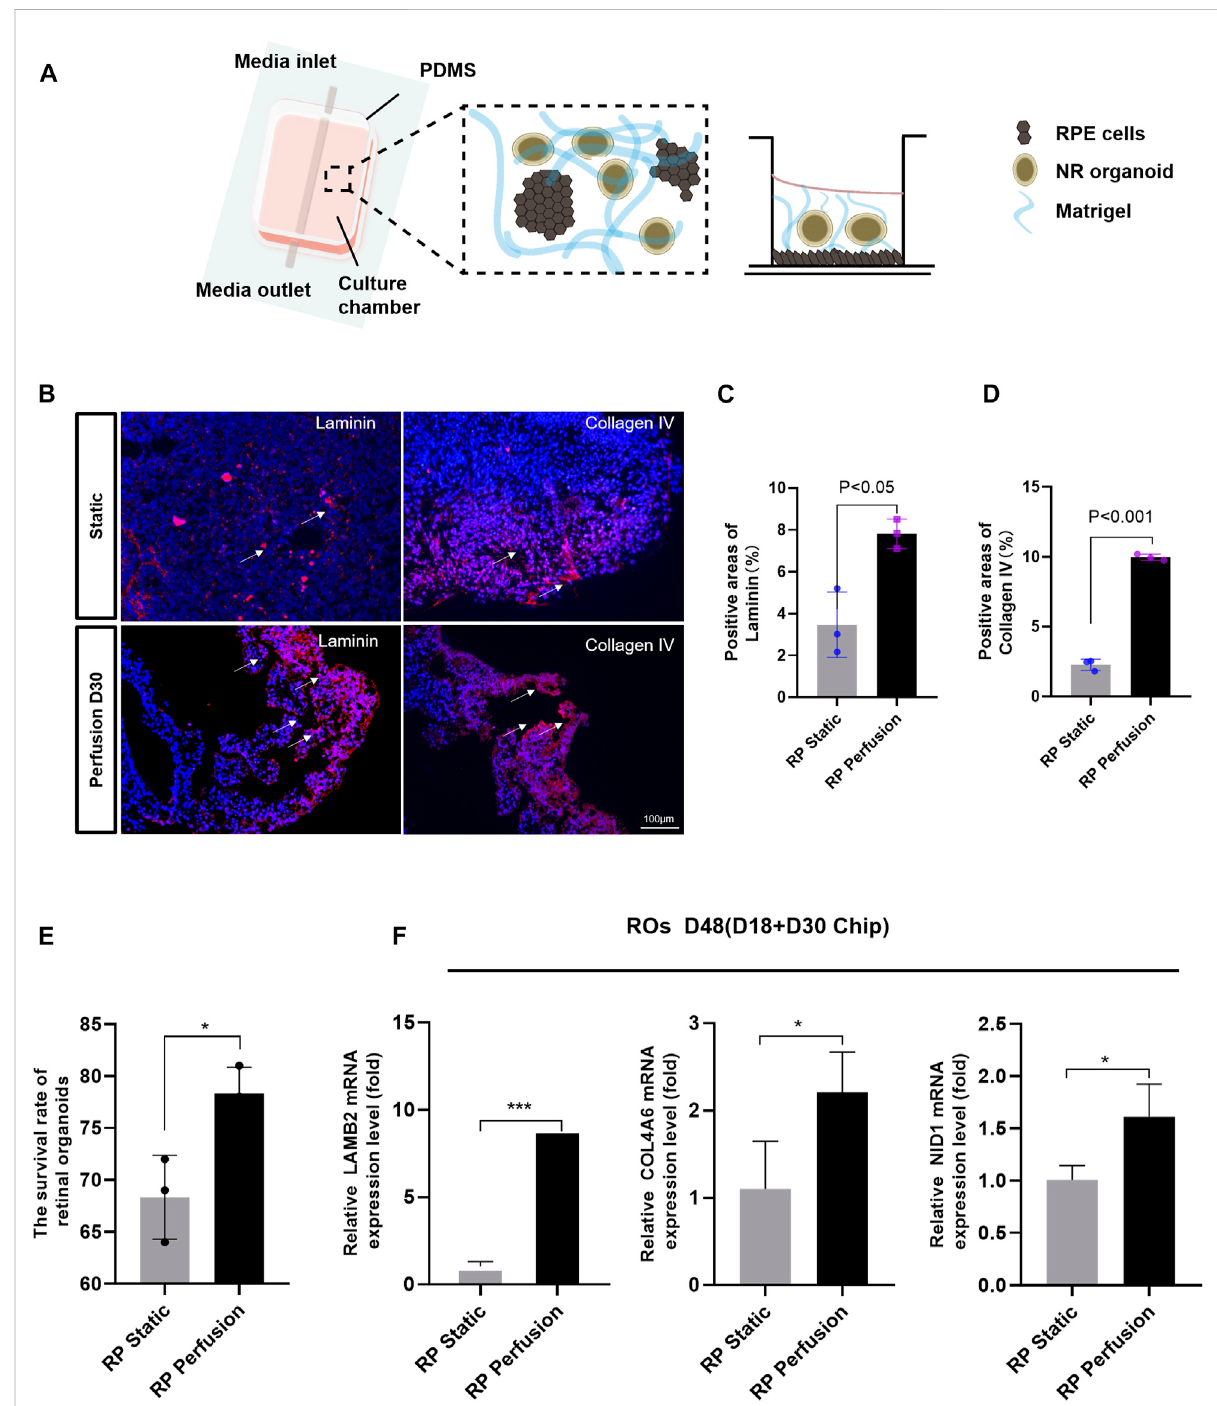
FIGURE 6 Micro fl uidicchipofperfusableROsinco-culturewithRPE. (A) Schematicofthemicro fl uidicsystem. (B) Immunostainingimagesoflaminin(red) and collagen IV (red) of ROs in response to perfusion with 200 μ L/min after 30 days compared to static control condition. (C,D) Measurements of positive areas with laminin and collagen IV. (E) The survival rate of ROs. (F) After 30 days perfusion, RT-qPCR results show COL4A6, LAMB2 and NID1 mRNA expression levels of ROs. Data are shown as mean ± SD. * p < 0.05, ** p < 0.01, *** p < 0.001 ( n = 3). Scale bar:100 μ